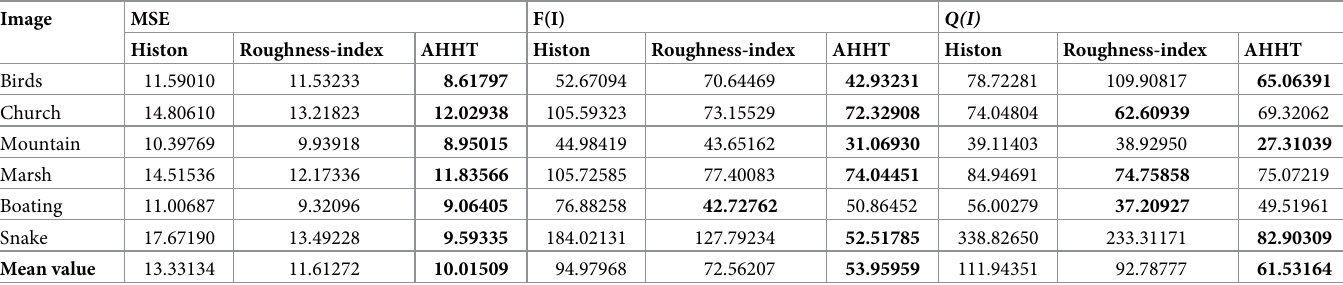
Table 3. Comparison MSE , F ( I ) and Q ( I ) evaluation function of segmentation results. Image